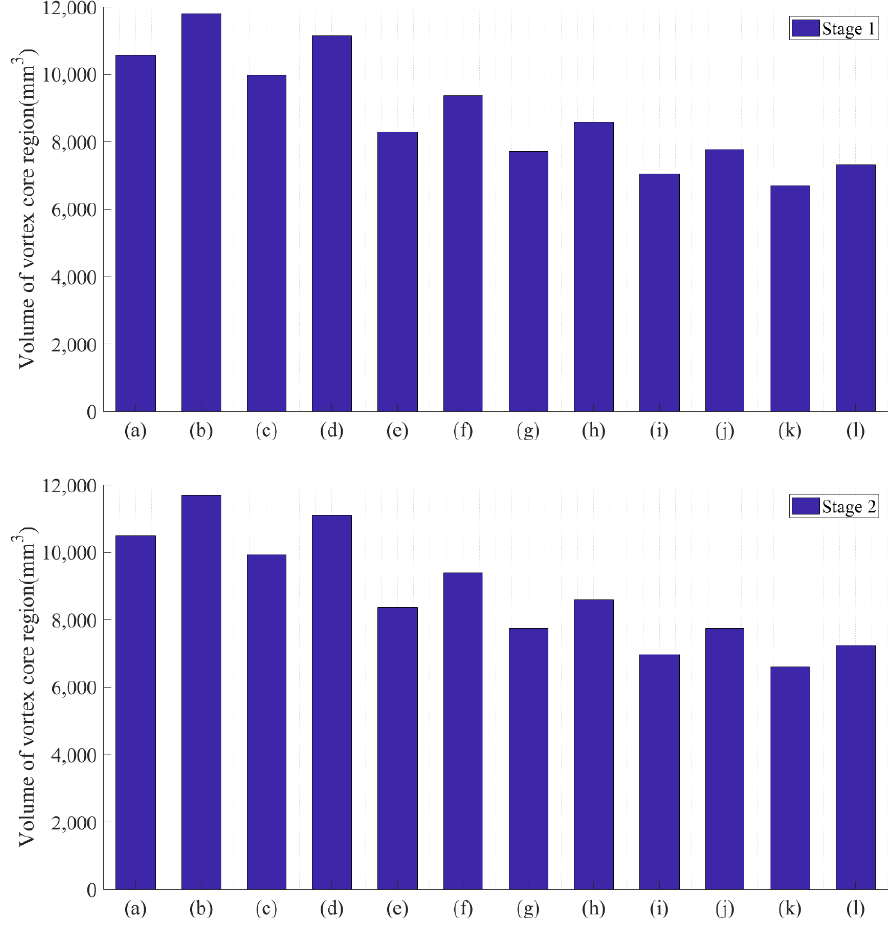
Figure 12. Volume comparison of vortex core area (instantaneous) of different side channel impellers at the same stage with the SST and DES models (a) Q4-SST-P, (b) Q4-SST-V, (c) Q4-DES- P, (d) Q4-DES-V, (e) Q8-SST-P, (f) Q8-SST-V, (g) Q8-DES-P, (h) Q8-DES-V, (i) Q12-SST-P, (j) Q12-SST-V, (k) Q12-DES-P, and (l) Q12-DES-V.